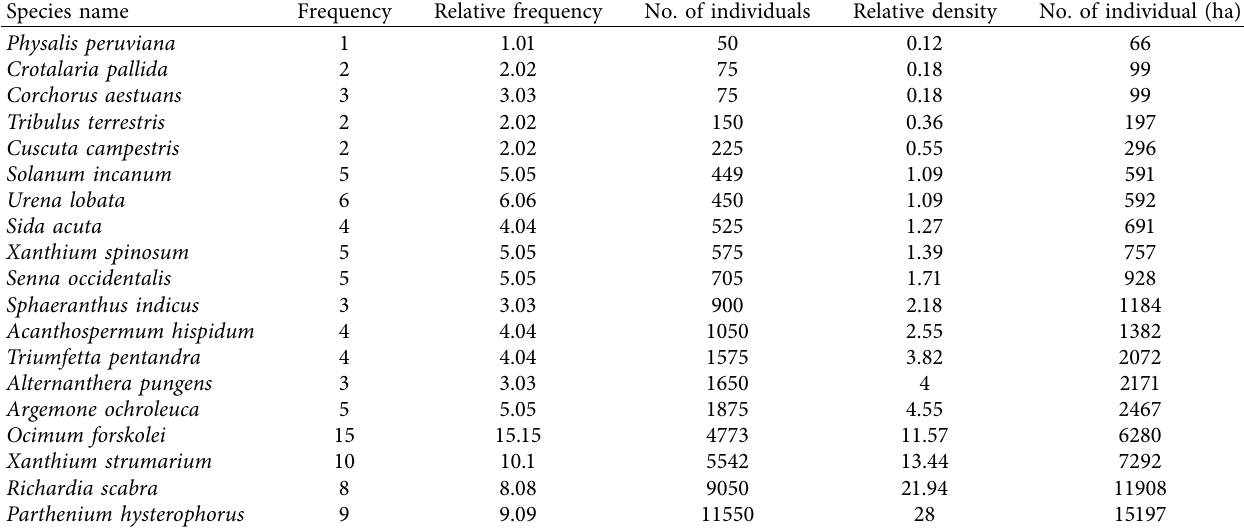
Table 2: Density and frequency of invasive alien plant species.